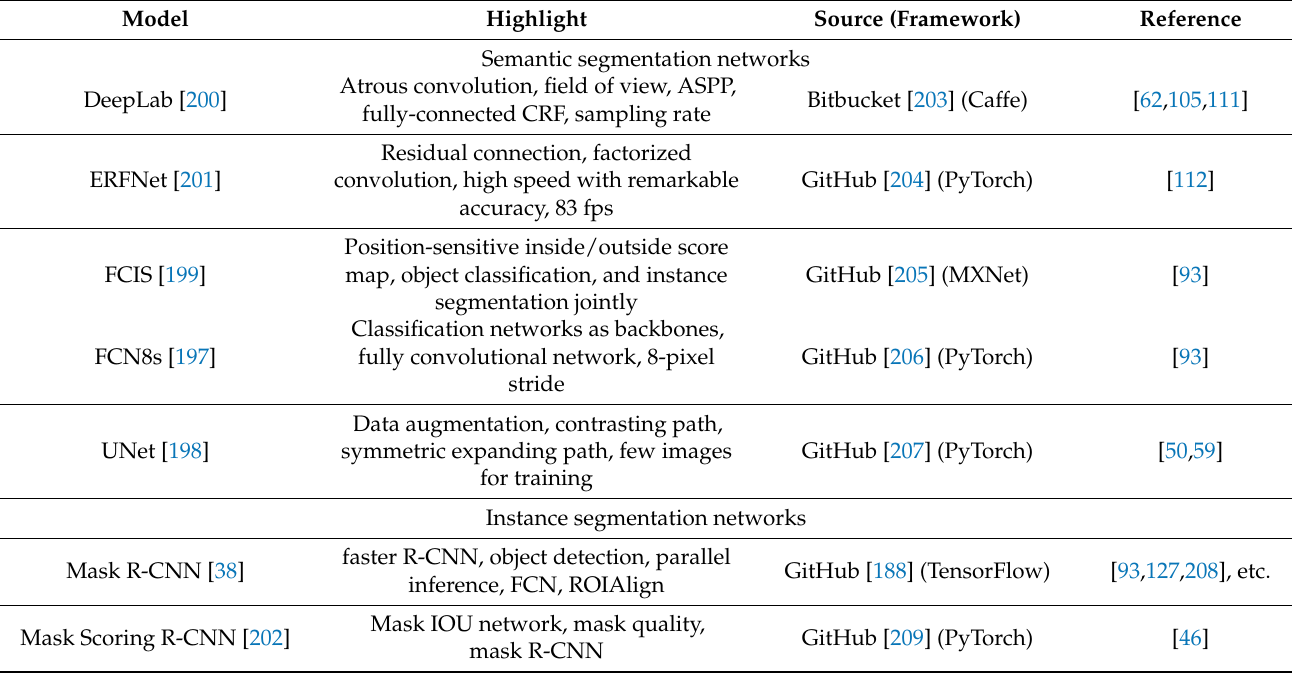
Table 5. Convolutional neural network architectures for semantic/instance